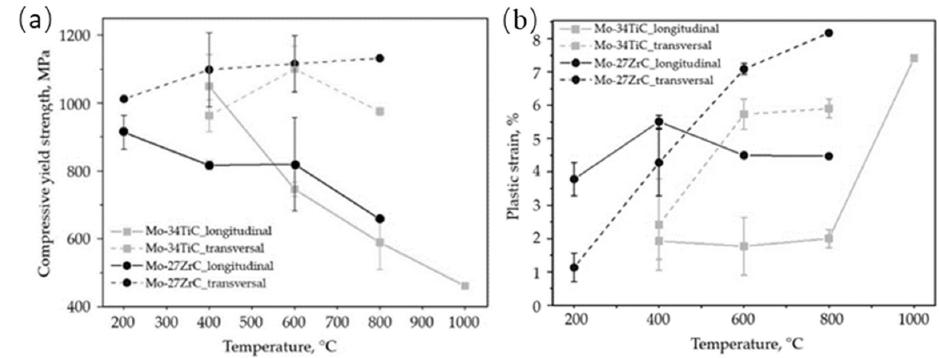
Figure 4. ( a ) Results of uniaxial compression tests on Mo ‐ XC composites, representing the compres ‐ sive yield strength vs. temperature; ( b ) the plastic strain vs.